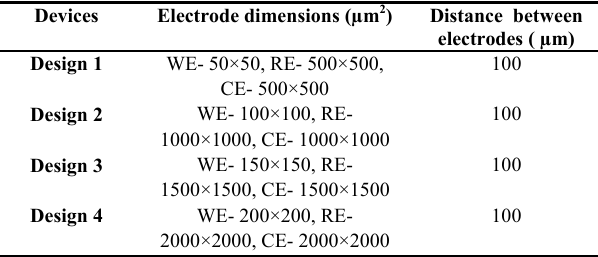
Table 1. Dimensions of different designs of three- electrode